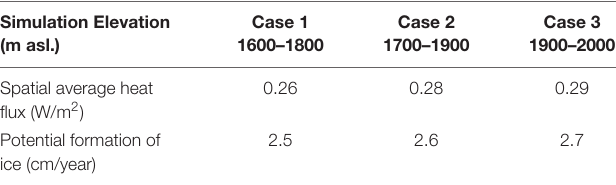
TABLE 5 | Average heat loss from the backside of the talus slope together with the corresponding potential formation of ice for simulations with snow-free steep rock